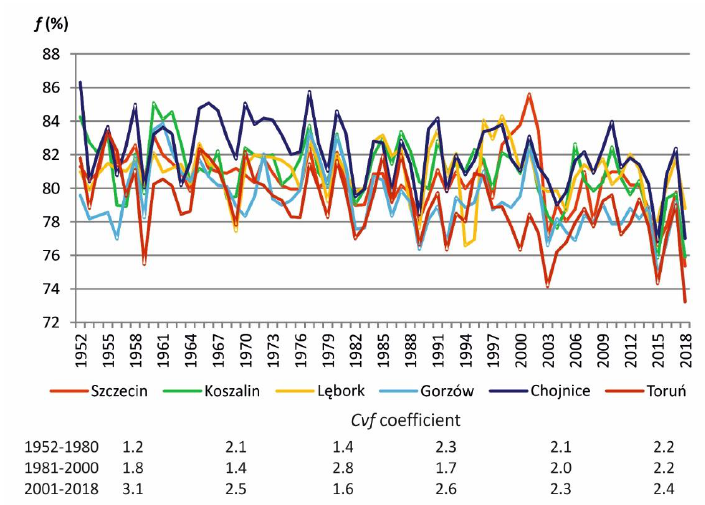
Figure 3. Long-term changes in the average annual values of relative air humidity ( f , %) and coefficient of f variation ( Cvf , %) in the studied stations (1952–2018) (prepared based on data obtained from the Polish Institute of Meteorology and Water Management—National Research Institute [43]).